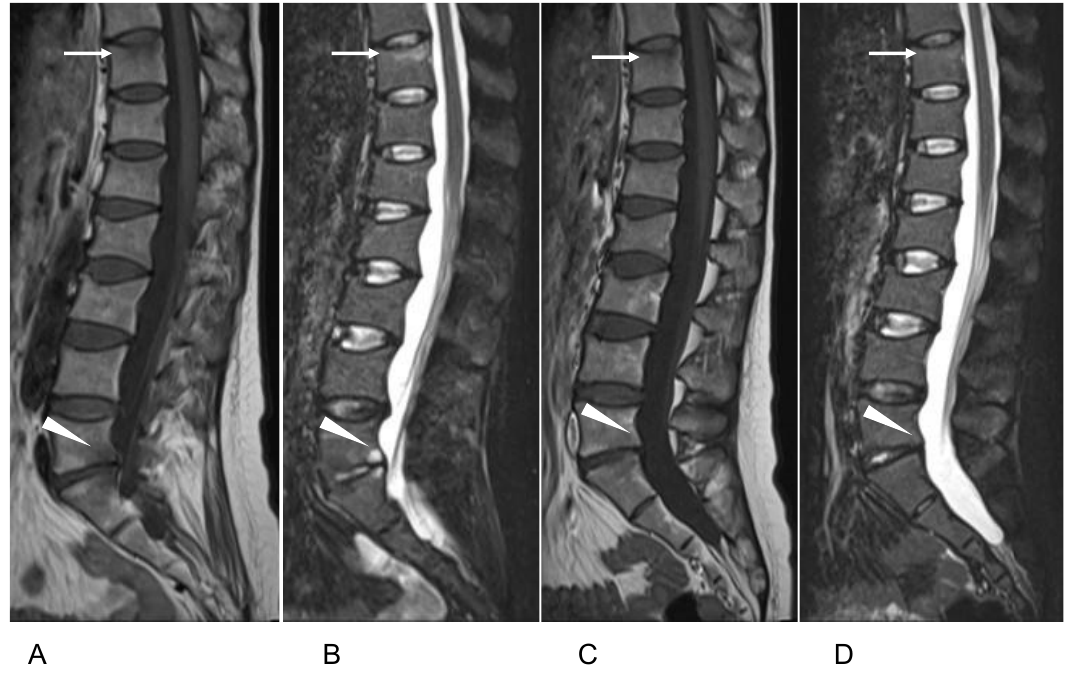
Figure 2. MRI of the patient’s thoracolumbar spine four months after the teriparatide treatment. Sagittal MRI shows low-intensity lesions at Th11 (arrow) and L5 (arrowhead) on ( A ) T1-weighed imaging and ( B ) high-intensity lesions on STIR imaging. Two months after the romosozumab treatment, sagittal MRI showed no abnormal signal change at Th11 (arrow) and L5 (arrowhead) on ( C ) T1-weighed or ( D ) STIR